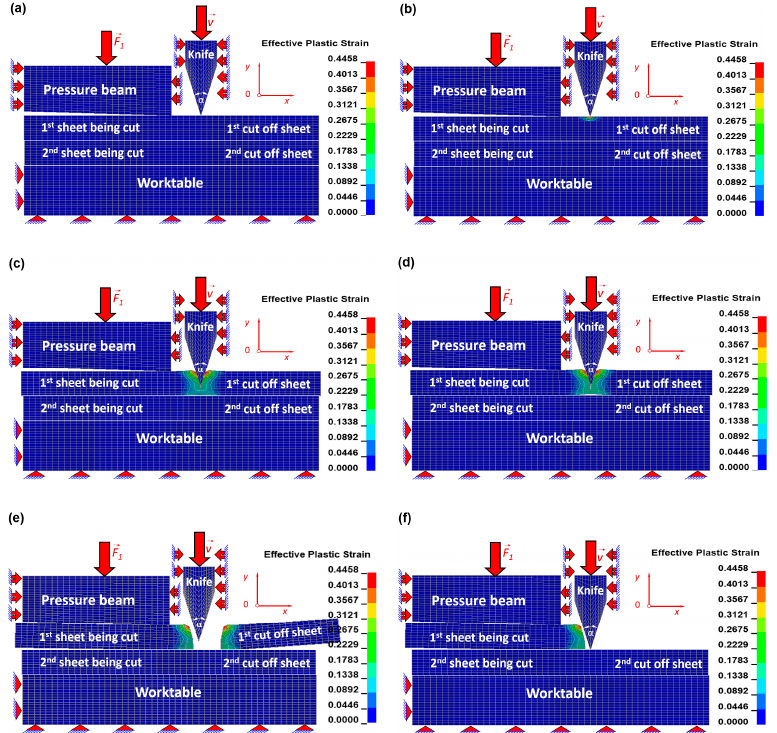
Figure A1. Contour maps of equivalent Huber–Mises plastic strain (mm/mm) in the top sheet in a bundle being cut for the chosen time instants (ms): ( a ) t = 2.04, ( b ) t = 2.07, ( c ) t = 8.00, ( d ) t = 8.40, ( e ) t = 8.43, ( f ) t = 12.00.